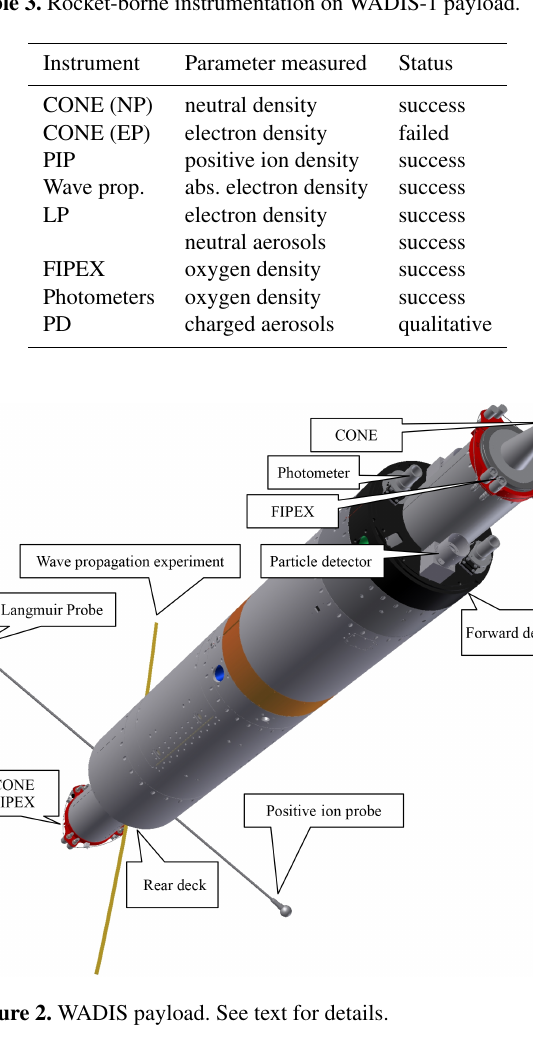
Table 3. Rocket-borne instrumentation on WADIS-1 payload.